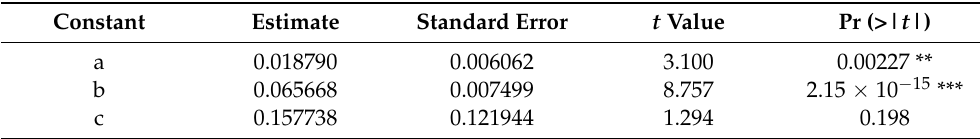
Table 5. Parameters of the extended exponential model describing the CO 2 efflux (g m − 2 h − 1 ) from undisturbed bare soil.